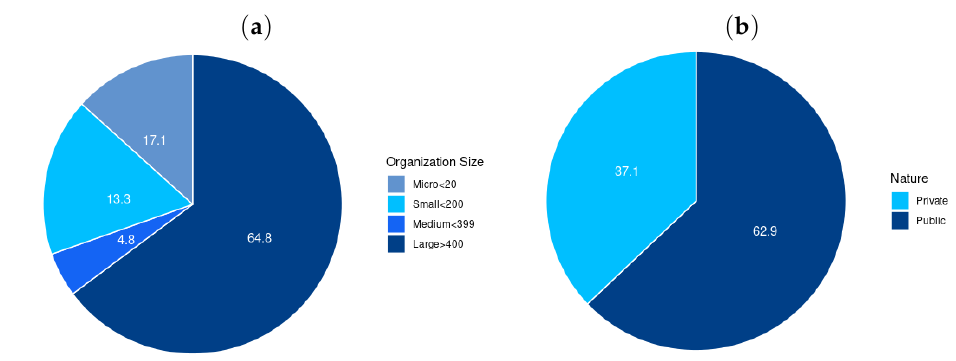
Figure 1. Figure ( a ) shows the number of employees that the organization has, while ( b ) shows the nature of the organization.